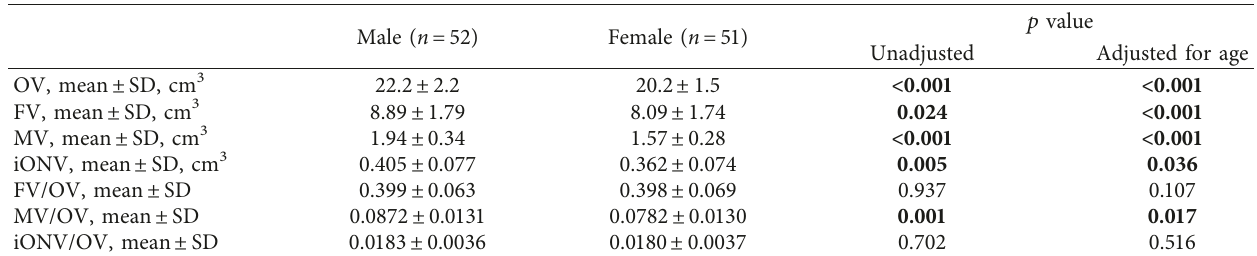
Table 2: Orbital fat volume, orbital muscle volume, orbital bony cavity volume, intraorbital optic nerve volume, and their ratios in normal Chinese